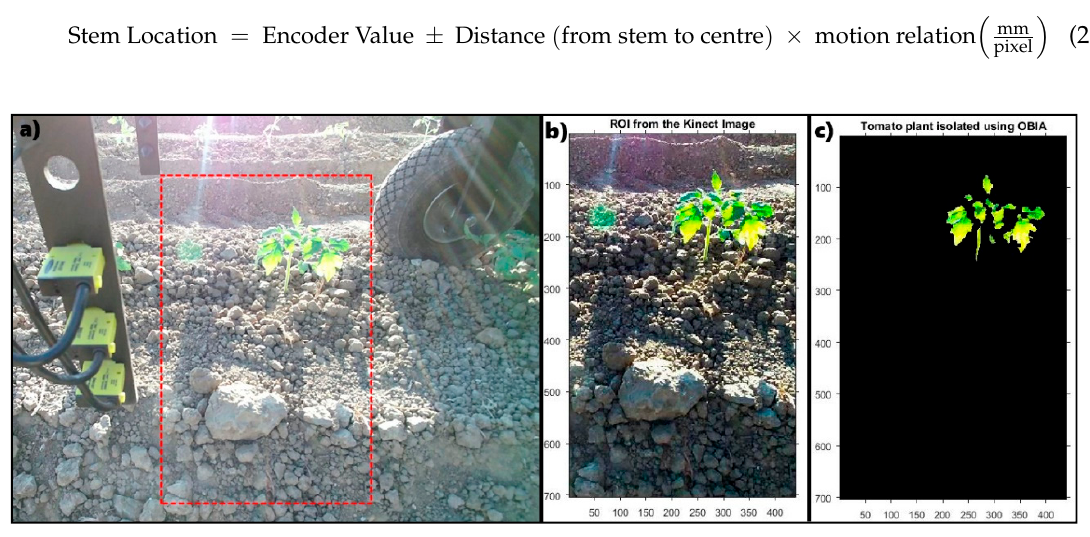
Figure 4. ( a ) raw image captured by the Kinect sensor with the ROI indicated; ( b ) ROI with white balance and saturation adjustment; ( c ) OBIA resulting image with isolated plant pixels.